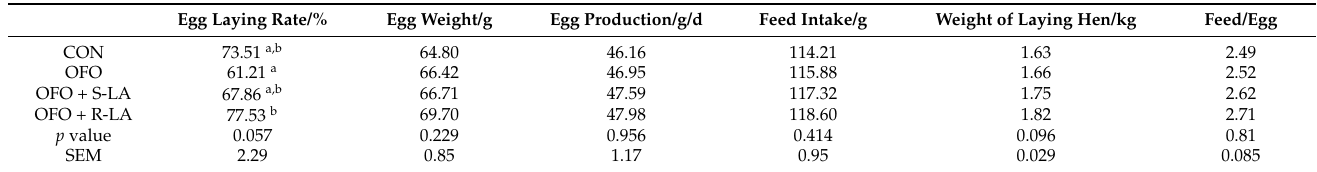
Table 1. Effect of different treatments on breeding performance of laying hens.